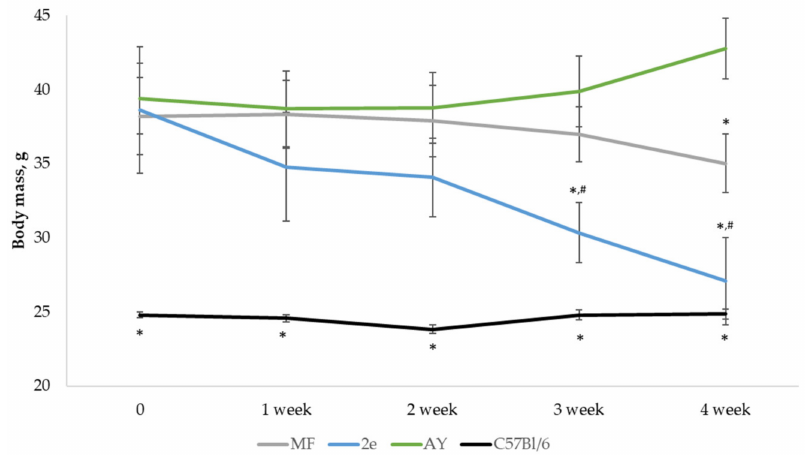
Figure 2. Body mass change during the experiment. * p < 0.05 as compared to AY mice, # p < 0.05 as compared to MF.